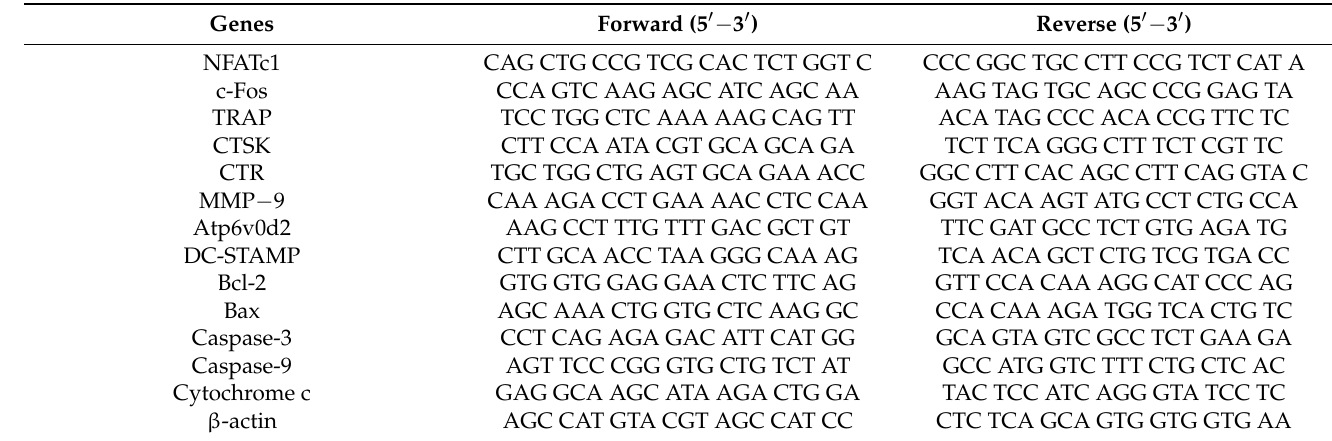
Table 1. Primers used in the real-time